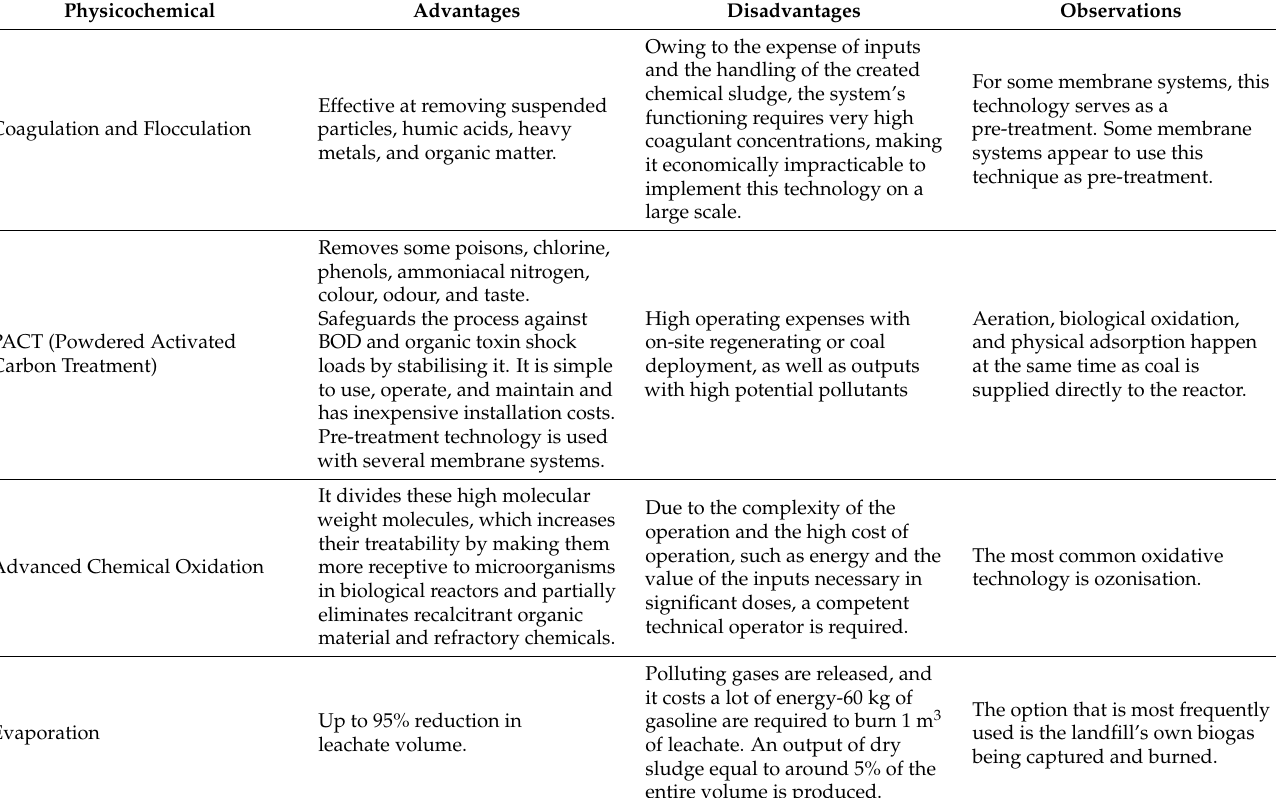
Table 6. Leachate physicochemical treatment system benefits and drawbacks.